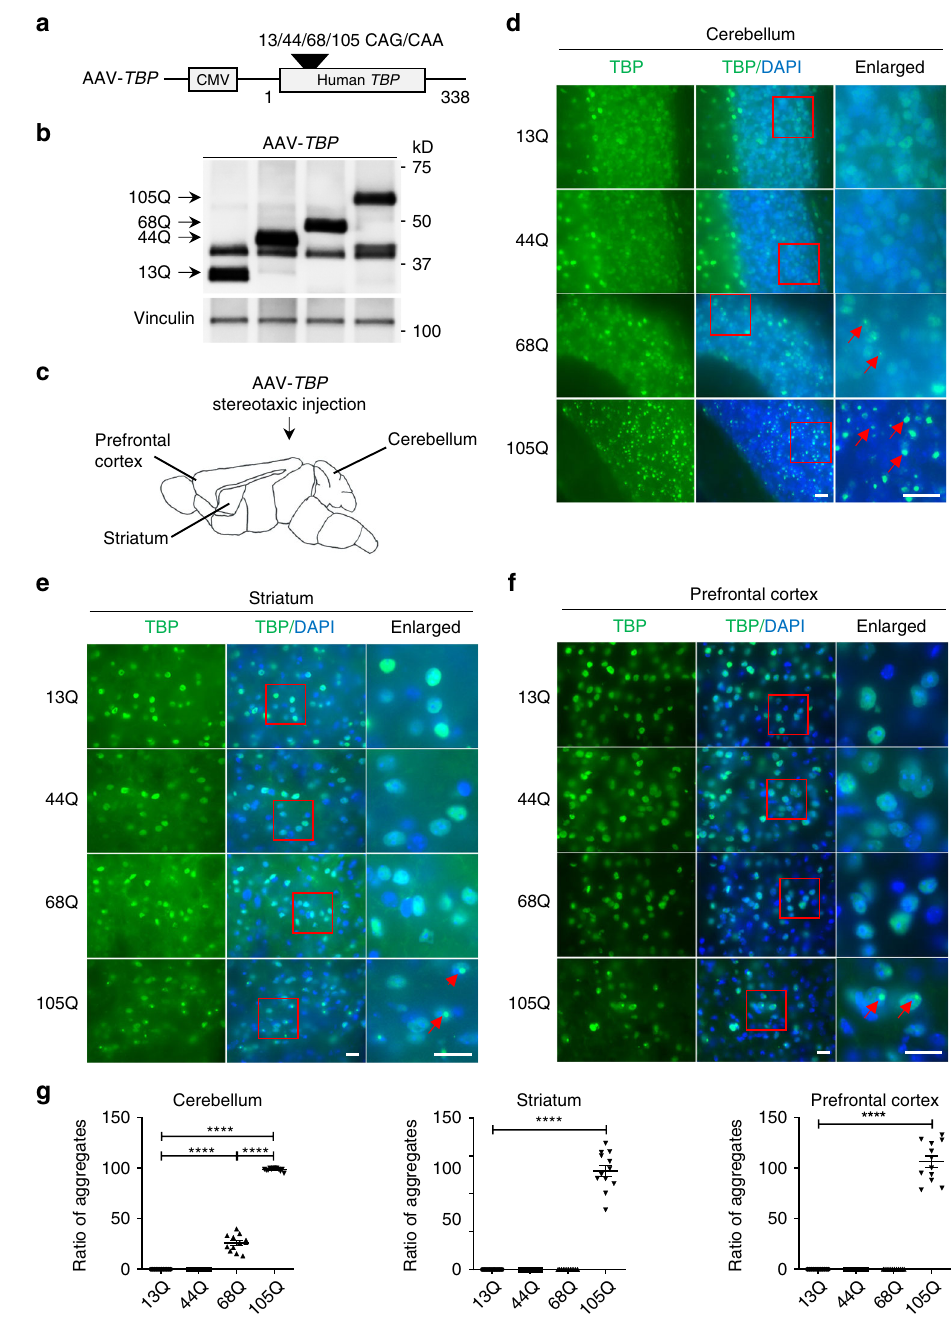
Fig. 1 PolyQ expansion promotes TBP to preferentially form aggregates in the cerebellum. a A schematic diagram of AAV plasmids expressing human TBP with different polyQ repeat lengths. b Western blot analysis of HEK293 cells transfected with AAV- TBP plasmids con fi rming the expression of TBP with different polyQ repeats (13Q, 44Q, 68Q, and 105Q). Vinculin was used as a loading control. c A diagram of stereotaxic injection of AAV- TBP into the cerebellum, striatum, and prefrontal cortex in 3-month-old wild-type mice. d – f TBP immuno fl uorescent staining of the cerebellum ( d ), striatum ( e ), and prefrontal cortex ( f ) from AAV- TBP -injected mouse brains. Anti-1TBP18 antibody was used. Enlarged images in the boxed areas were also presented. Red arrows indicate aggregates. Scale bar = 20 μ m. g Quanti fi cation of the accumulated TBP aggregates in the cerebellum, striatum, and prefrontal cortex. One-way ANOVA followed with Tukey ’ s multiple comparisons test was performed; cerebellum, F = 1491; striatum, F = 311.6; prefrontal cortex, F = 354.6, **** P < 0.0001. n = 4 mice per group, three images per brain region from each mouse were used to count. Data are represented as mean ± SEM. Source data and full blots are provided as a Source Data fi